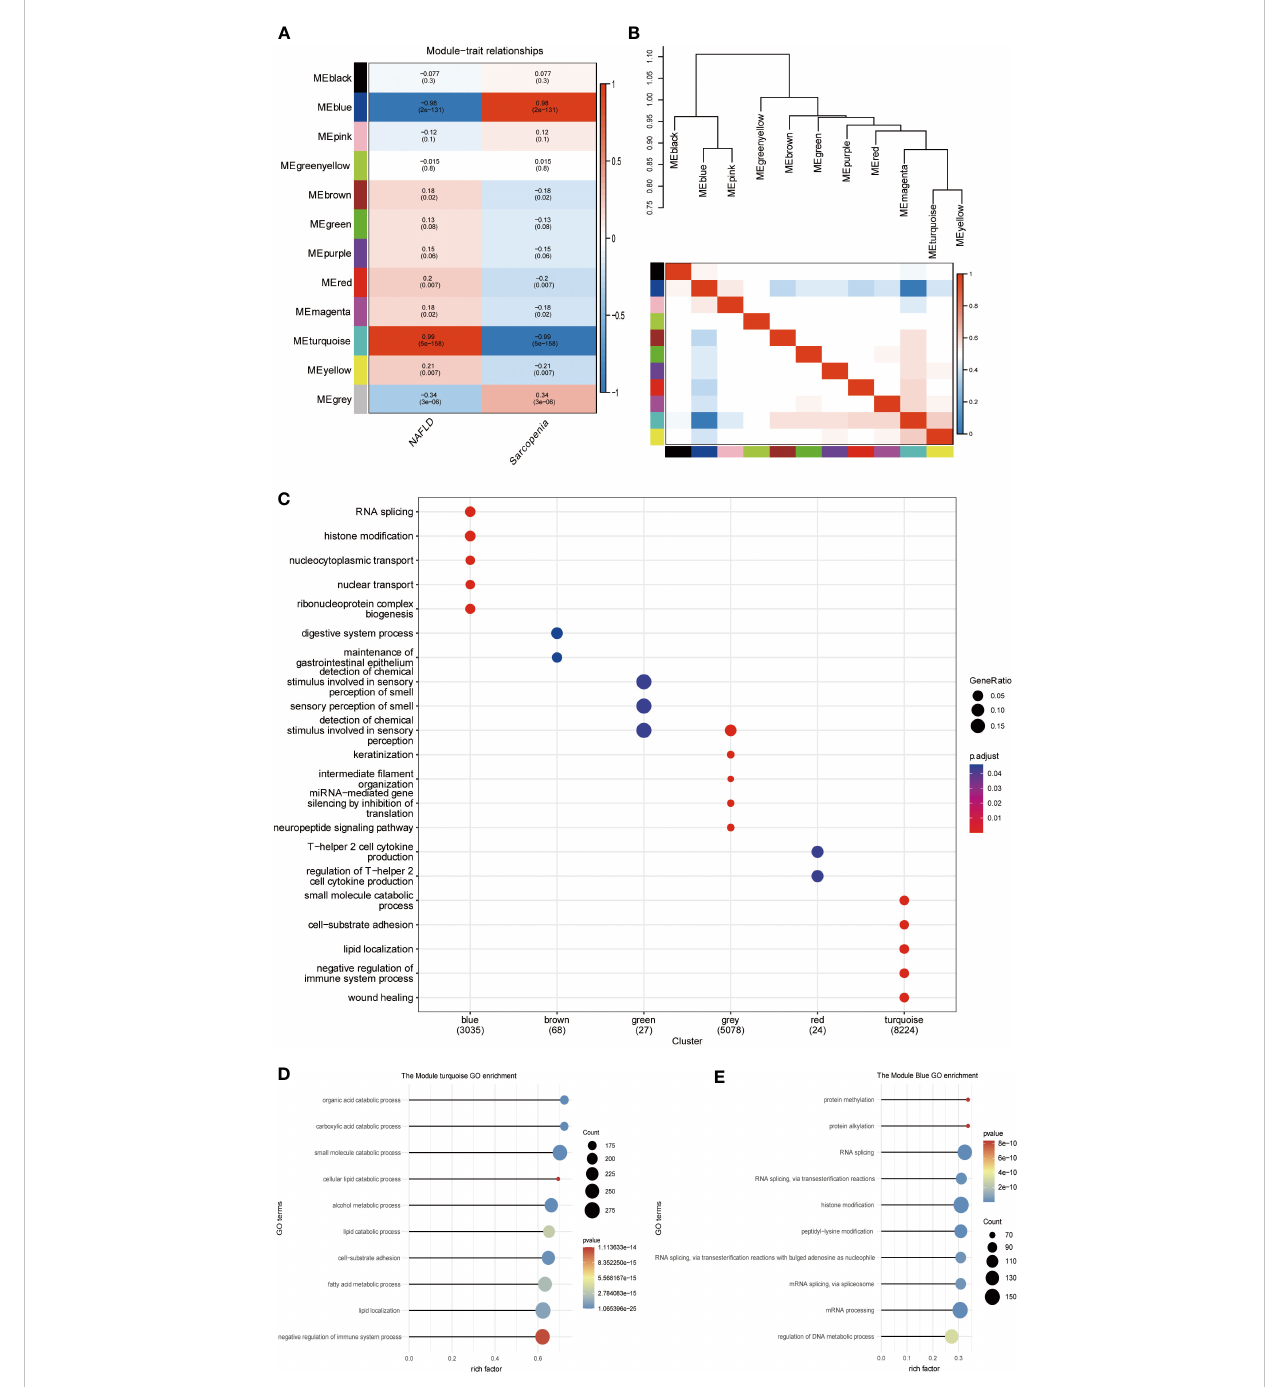
FIGURE 6 WGCNA of NAFLD and Sarcopenia. (A) Module – trait associations. Each row corresponds to a module, and each column corresponds to a trait. Each cell contains the corresponding correlation and P value. The table is color-coded by correlation according to the color legend; (B) Eigengene dendrogram and eigengene adjacency plot; (C) Gene Ontology analysis; (D) Gene Ontology analysis of the genes involved in the turquoise module; (E) Gene Ontology analysis of the genes involved in the blue